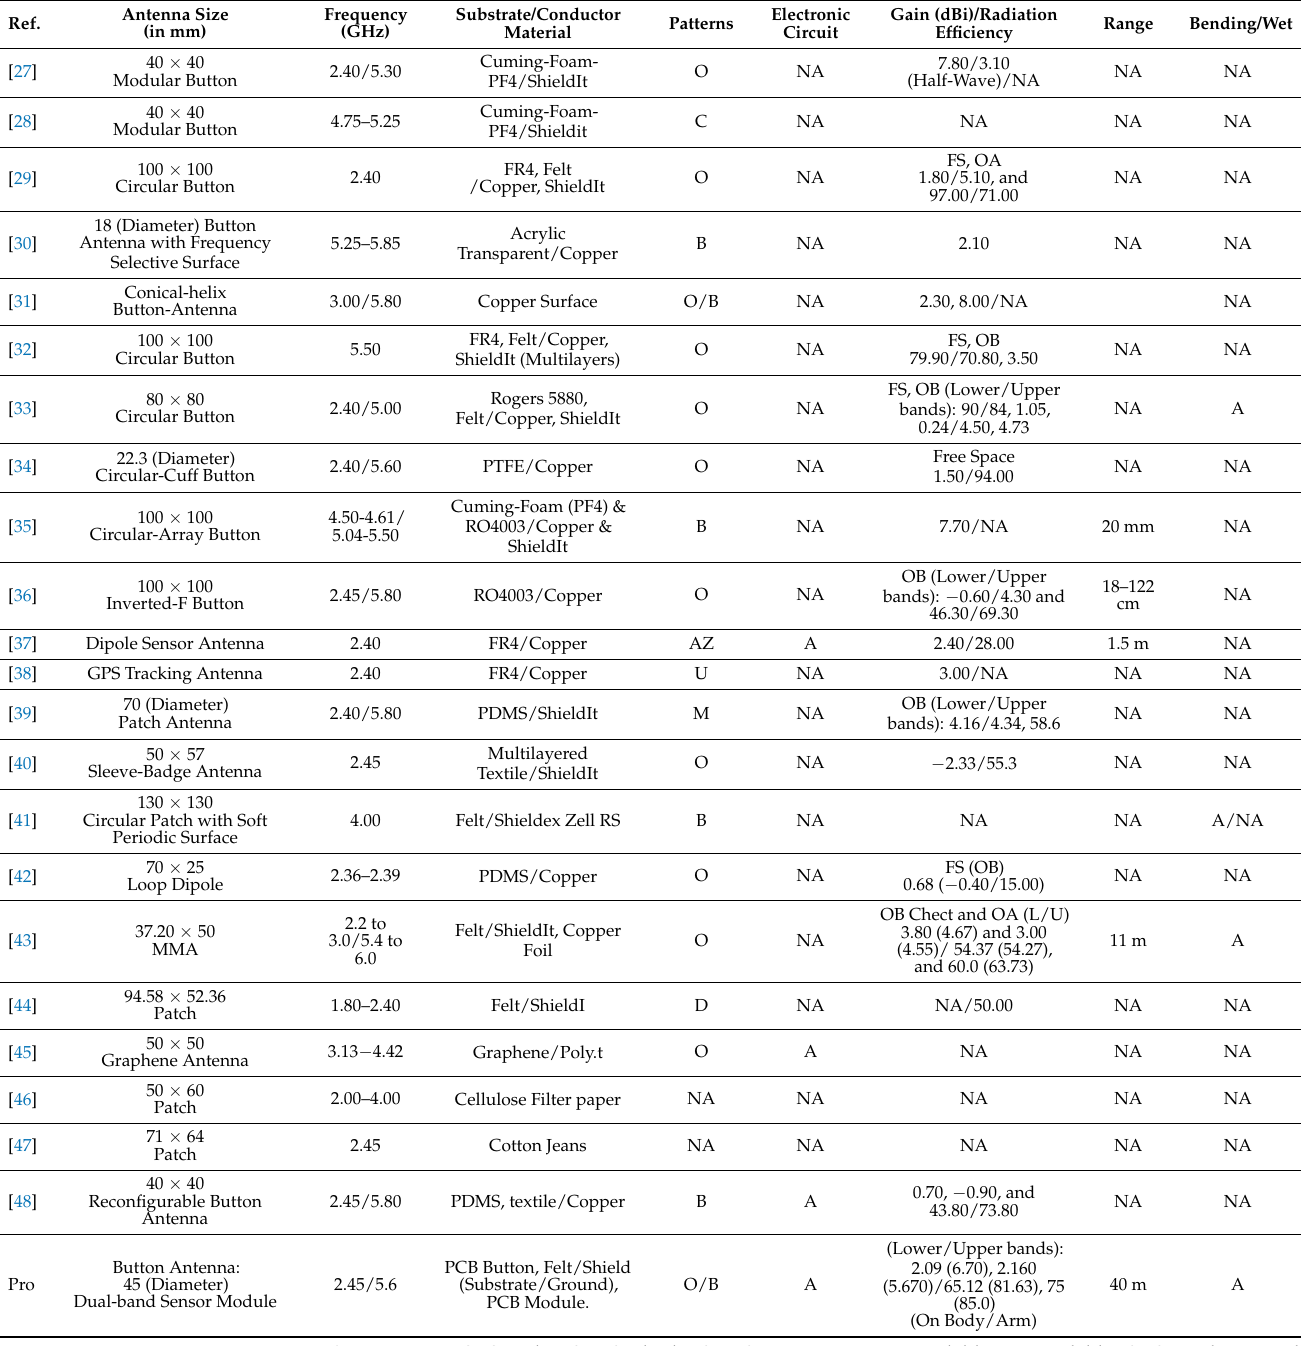
Table 1. Comparison of various miniaturized button-sensor antennas proposed in the